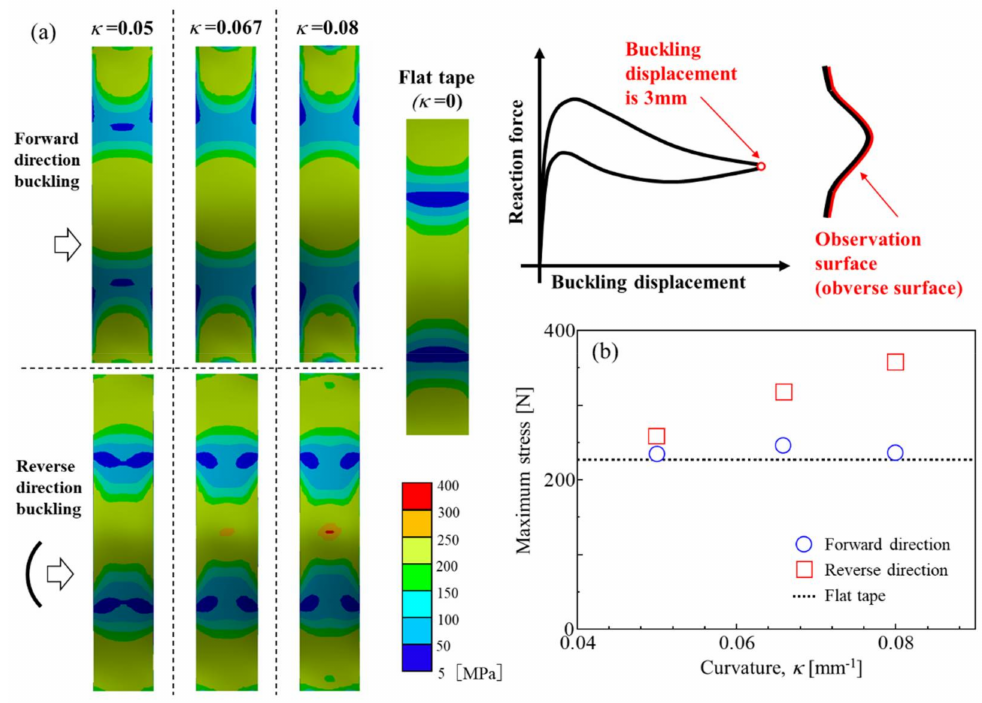
Figure 14. The numerically obtained ( a ) stress distribution and ( b ) κ dependence of maximum stress on the obverse surface of each specimen for each buckling direction, when the buckling displacement is 3